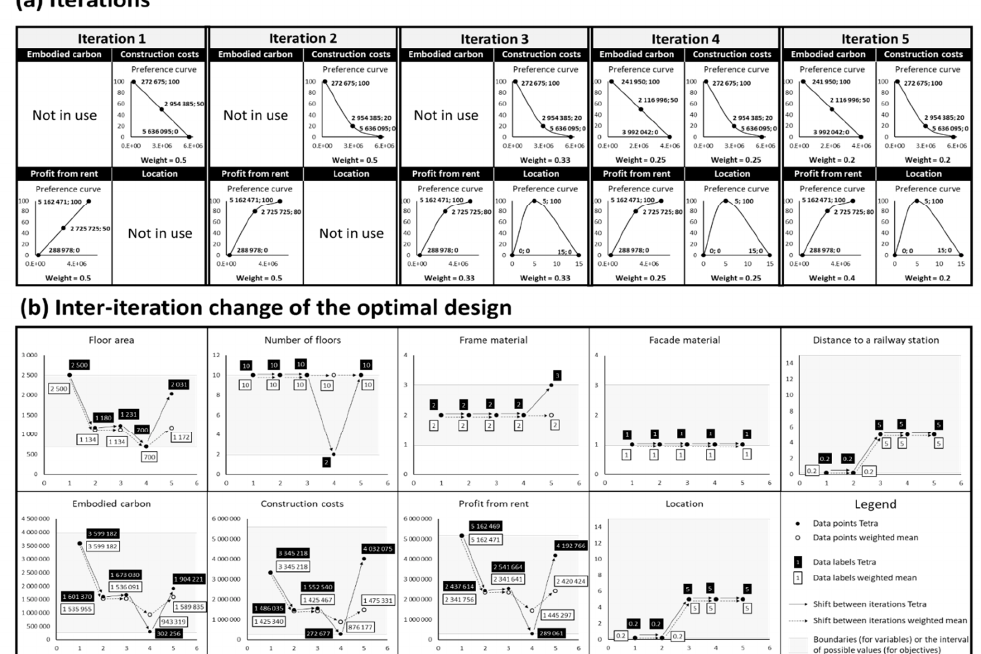
Figure 4. ( a ) Preference curves and weights for all iterations; ( b ) The results of optimization runs for each iteration showing the optimal values of design variables and objectives. Iteration